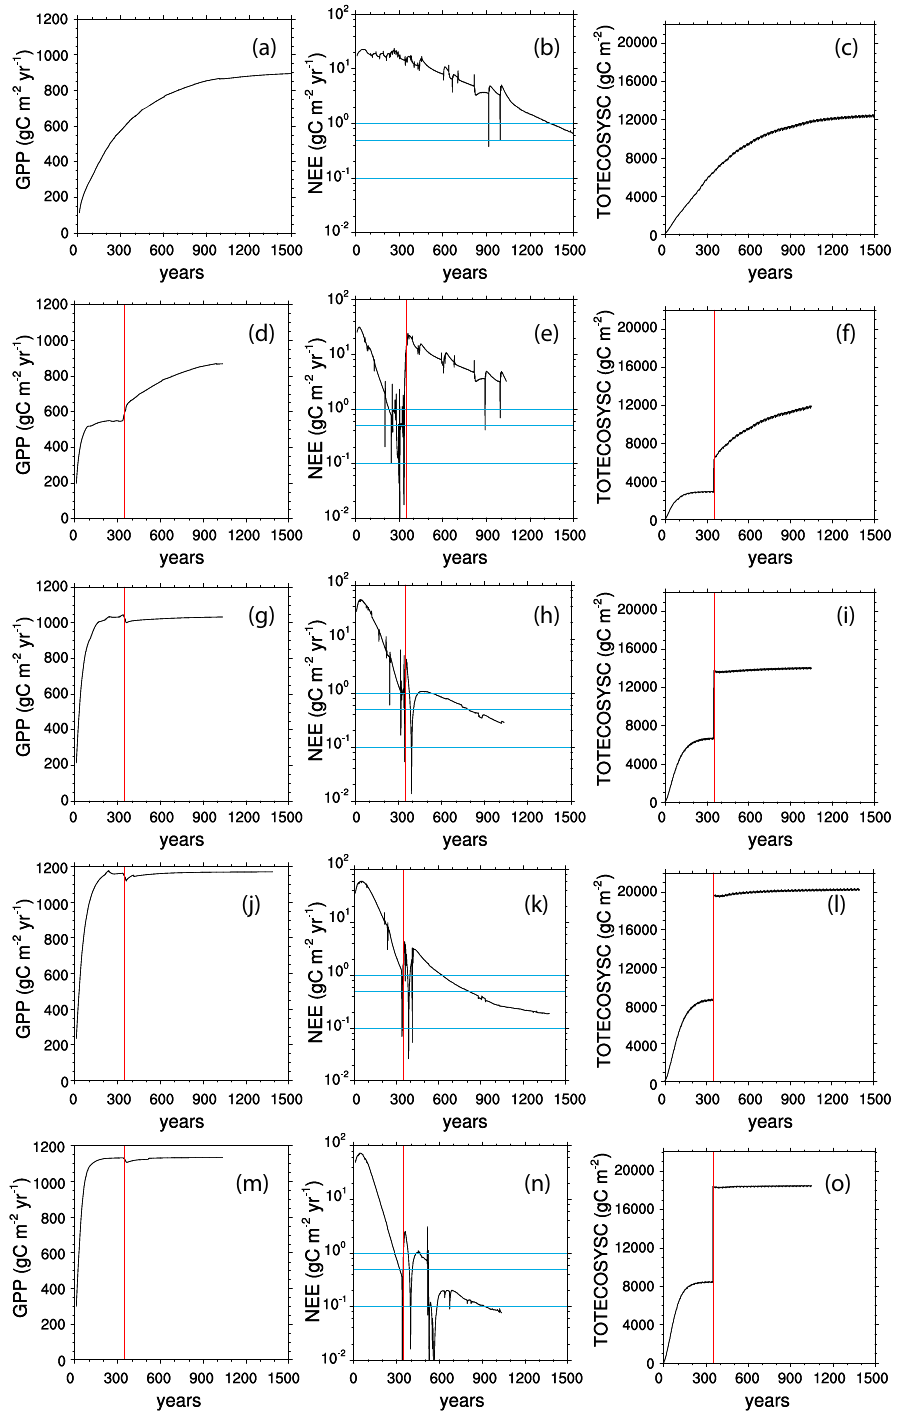
Fig. 4. A comparison of model equilibration time for different techniques, including the full model (a–c) , accelerated decomposition (AD) (d–f) , and modified accelerated decomposition (g–o) , for a single grid cell using multiple versions of model (a-i): CLM4.0 model, (j–l) single-level CLM4 with Century soil pools, (m–o) multi-level CLM4 with Century soil pools. Columns are: left (a, d, g, j, m) GPP; center (b, e, h, k, n) abs(log(NEE)), and right (c, f, i, l, o) total ecosystem carbon. Horizontal axis is time, in years, with the same scale for all simulations. Horizontal blue lines represent thresholds of abs(NEE) equal to 1, 0.5, and 0.1gCm − 2 yr − 1 . Vertical red lines represent the step in which the model is taken from spinup mode to normal